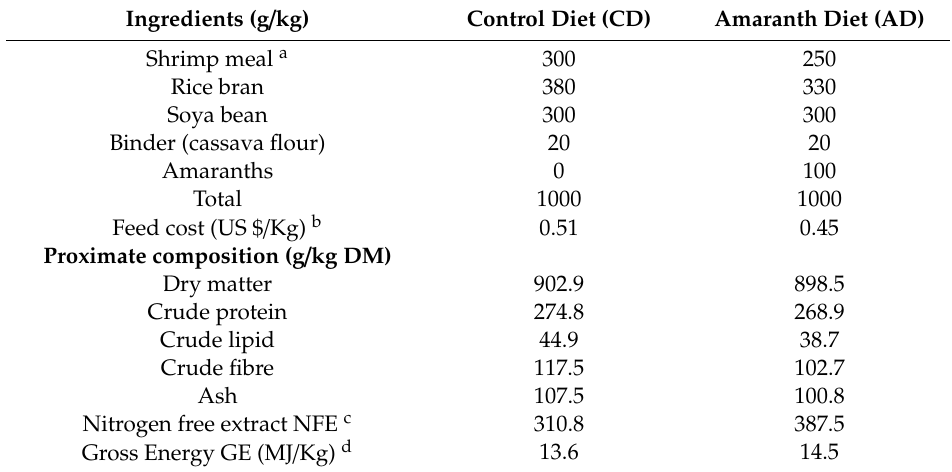
Table 2. Composition of the fish control diet (CD) and the diet with AW inclusion (AD) and the total cost to produce 1 kg of each feed.